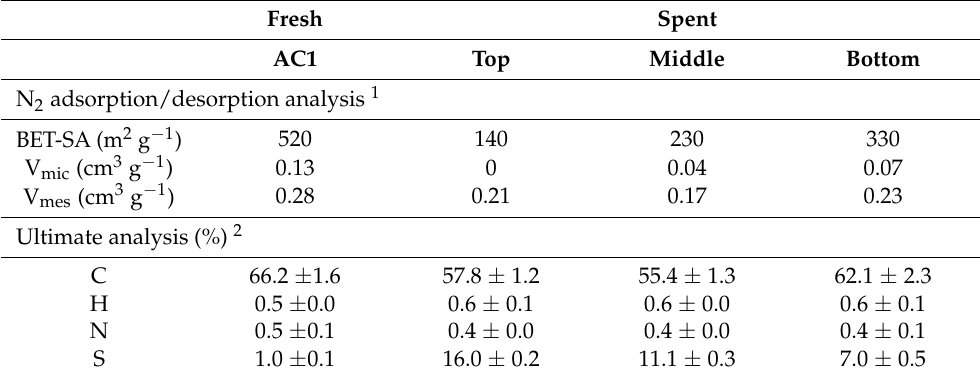
Table 6. Spent adsorbent characterization from bench-scale experiments presented in Figure 8b. Fresh Spent AC1 Top Middle